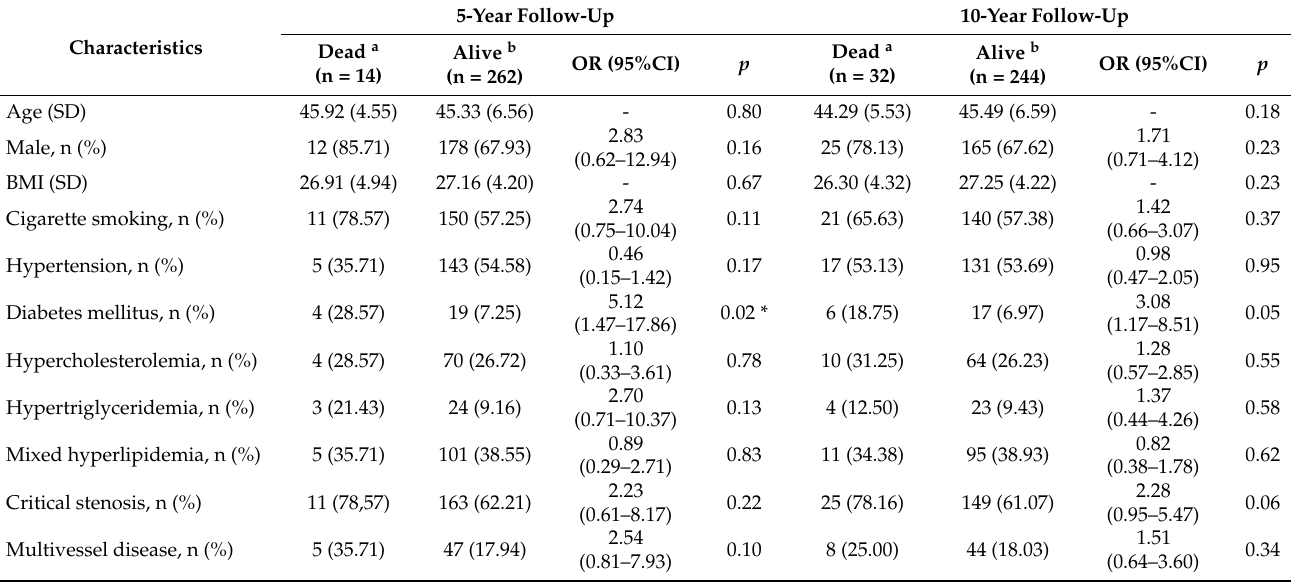
Table 3. Baseline characteristics of CAD patients (at the day of initial